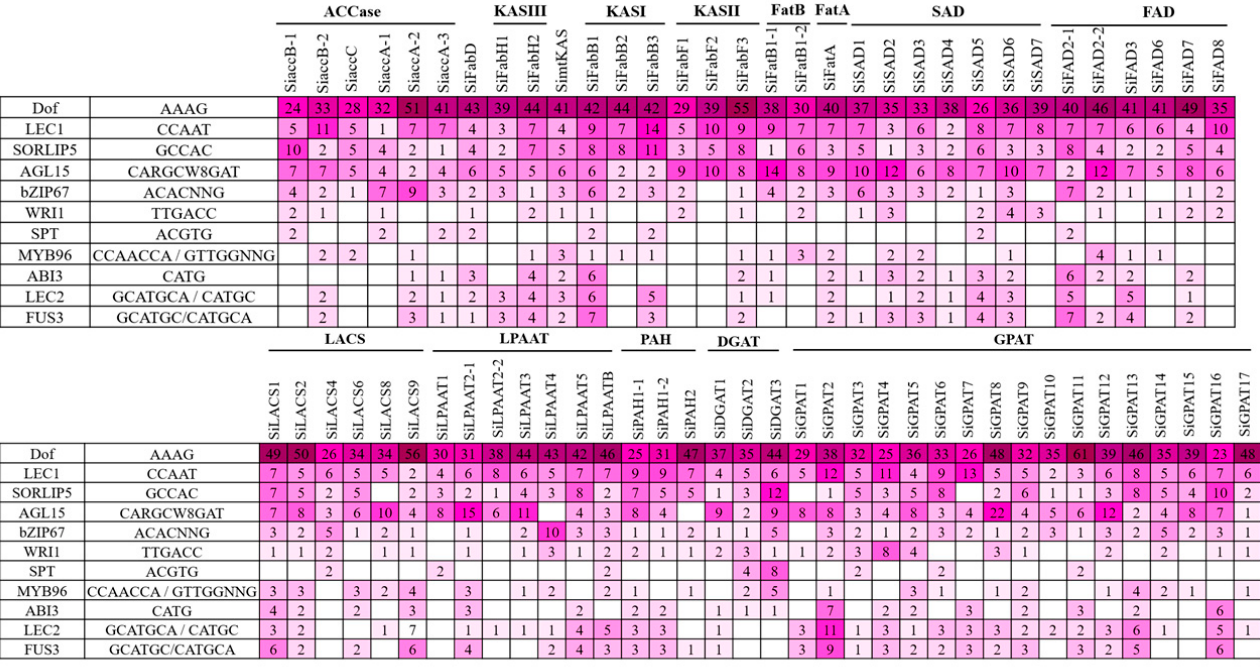
Figure 4. The number of binding sites identified using PLACE and PlantPAN 3.0 tools for each of the CARE ( cis -acting regulatory elements) associated with oil accumulation (represented in a heat map).